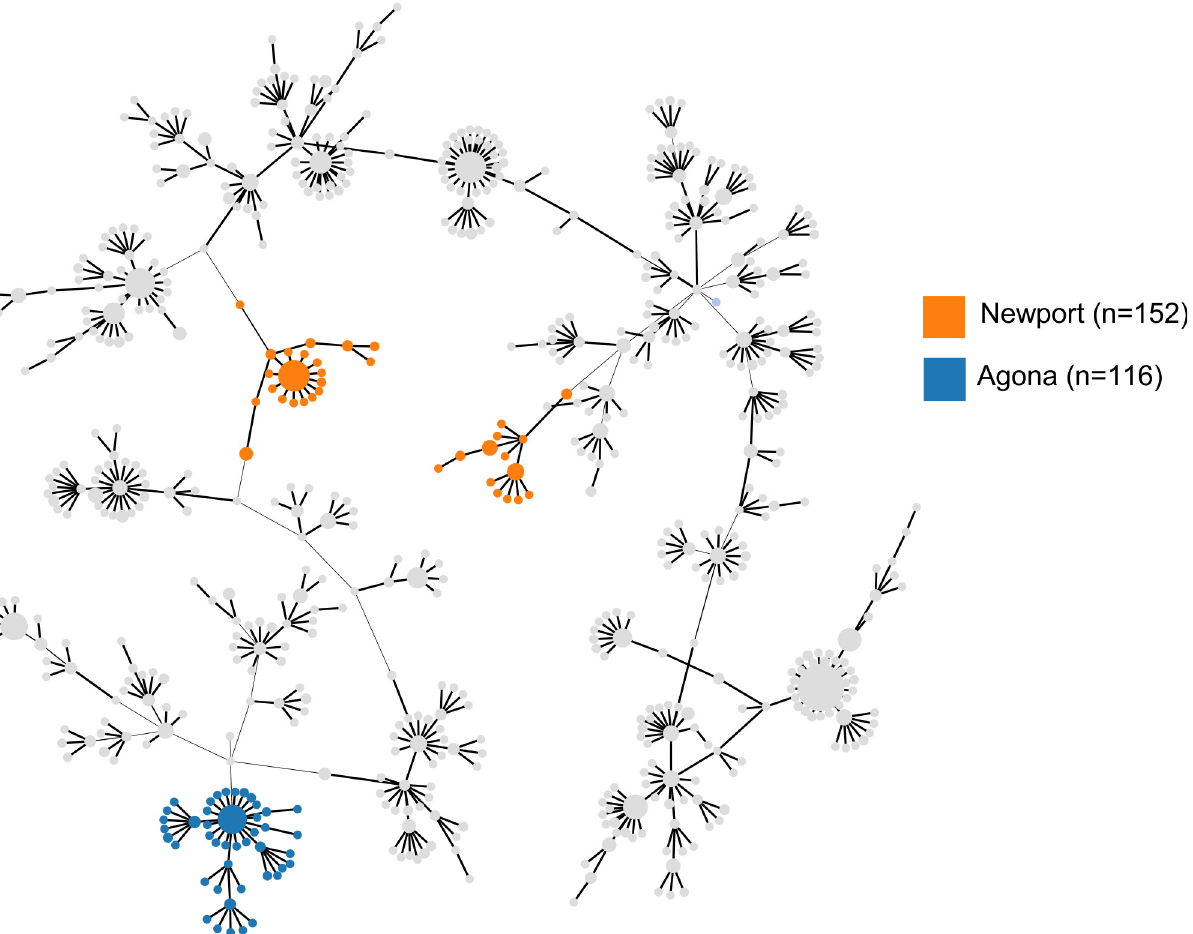
Fig 7. Evidence from cgMLST supports the polyphyletic origin of Salmonella Newport. Minimum Spanning Tree visualization of cgMLST phylogeny for a set of Salmonella enterica genomes (n = 2,002) created in the SISTR server. The predicted serovar for Newport and Agona genomes has been projected onto the tree to highlight the contrast between a polyphyletic serovar (Newport) and a monophyletic serovar